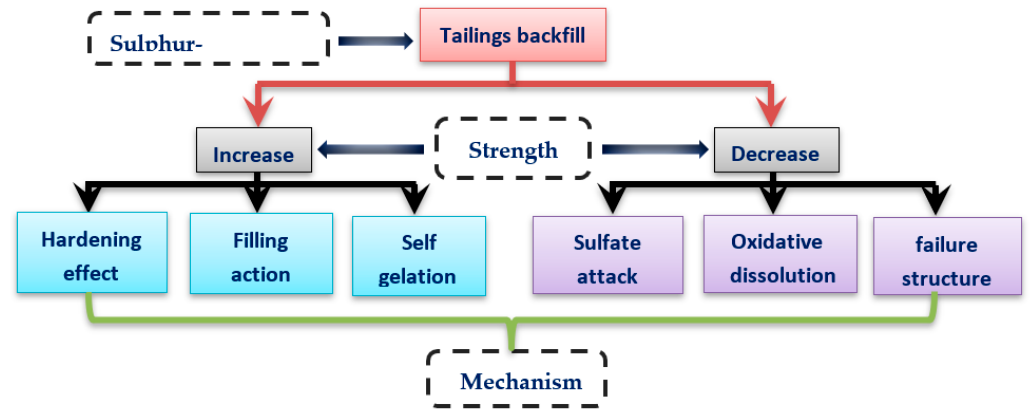
Figure 11. Mechanism of sulfide tailings on the strength of cemented tailings backfill.